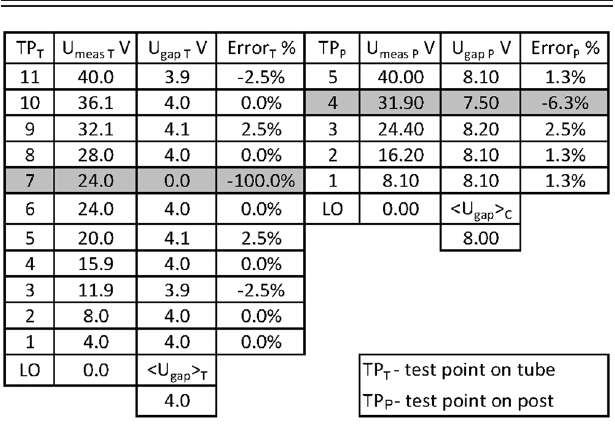
TABLE III. Measured voltage distribution across an 11 gap acceleration tube and the corresponding 5 gaps on the column